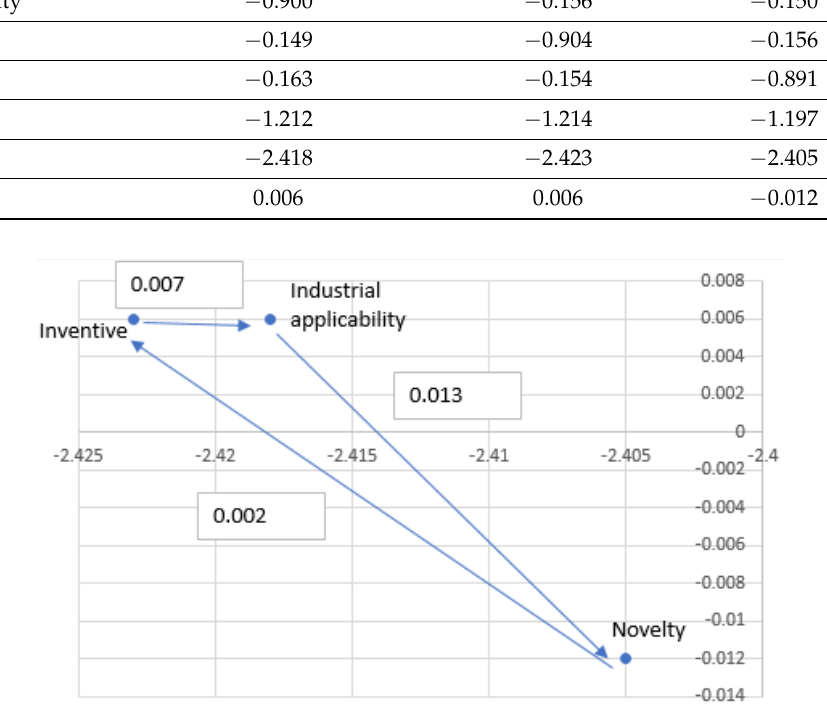
Figure 5. Causal diagram of sub-aspects of technology inventor. Table 6. The causal matrix of sub-aspects of essence of technology. Industrial Applicability